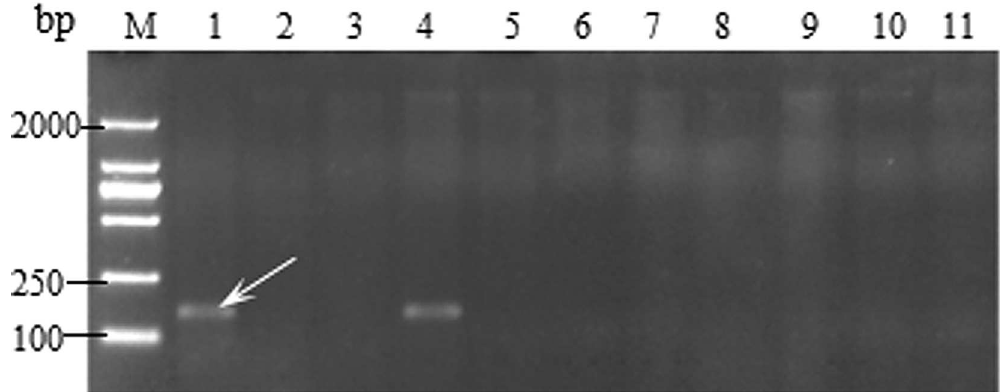
DNA ladder and white arrow indicates the position of the specific band.